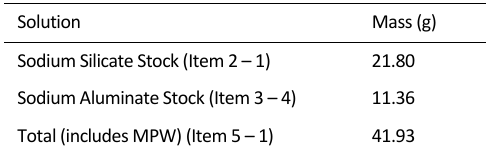
Table 2. Mass of stock solutions used to synthesize N‐A‐S‐(H). Solution